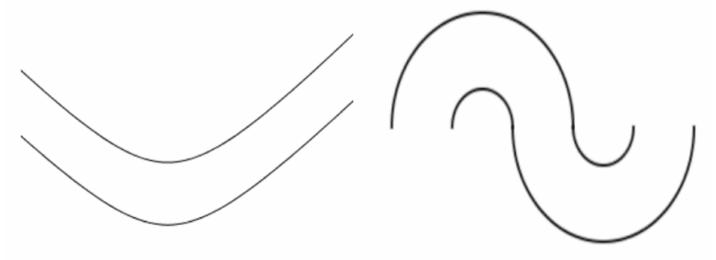
Figure 2. Generalization of the concept of